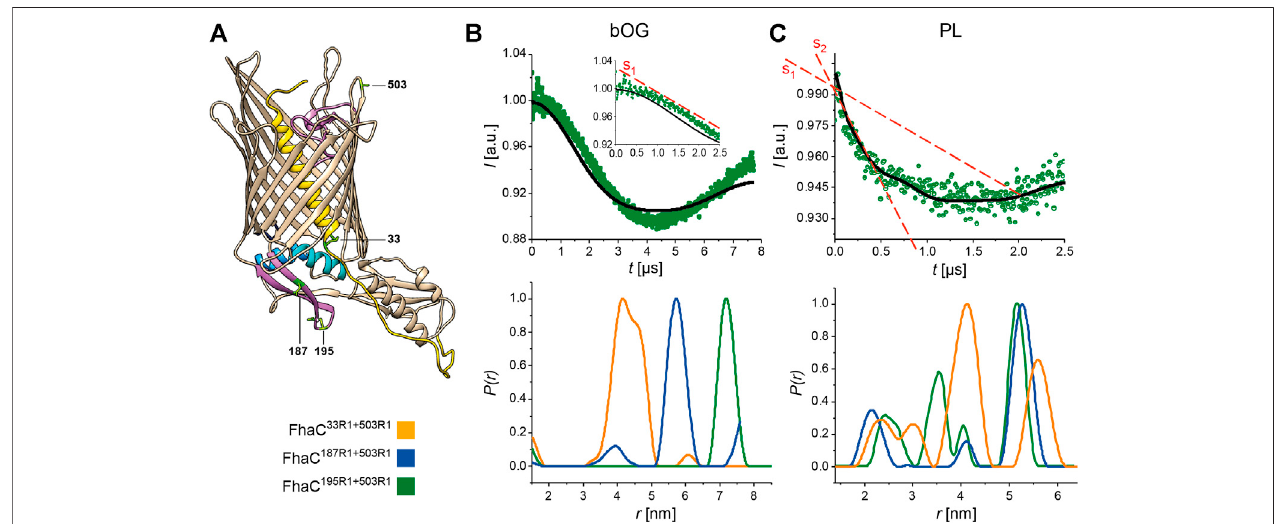
FIGURE 4 | PELDOR analyses of FhaC. (A) Structural model of FhaC with the positions of the residues mutated to Cys for MTSL labeling. Cys503 in the extracellular L7 loop was chosen as a reference point in FhaC (Guérin et al., 2015). (B,C) Dipolar evolution function for FhaC 195R1+503R1 (top), and distance distributions obtainedbyTikhonovregularization ofthedipolar evolutionfunctions(bottom) forFhaC 33R1+503R1 (orange), FhaC 187R1+503R1 (blue), and FhaC 195R1+503R1 (green)inbOG (B) and in proteoliposomes prepared with E. coli polar lipids (PL, (C) ). The black lines in the upper panels correspond to the fi tting of the experimental PELDOR traces. The inset in (B) represents the fi rst 2.5 µs of the dipolar evolution function, for better comparison with the graph shown in (C) . The red dashed lines denoted S1 and S2 show the slopes of the fi rst parts of the curves representing the dipolar evolution functions in bOG and in PL. Note that the longest distances measured depend on the dipolar evolution time t (see Supplementary Figure S8